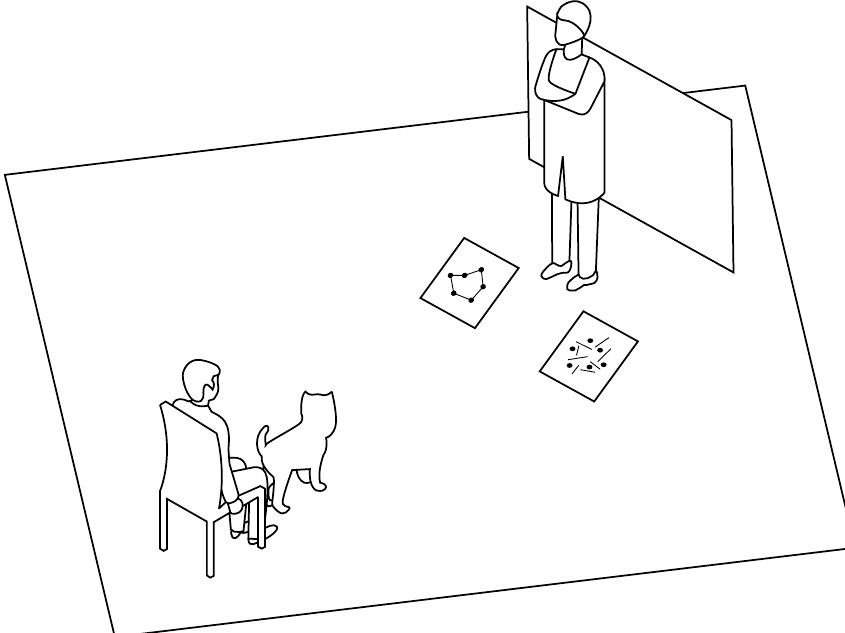
Figure 2. Representation of the experimental setting, illustrating the position of the dog, the owner, the experimenter and the stimuli, during a presentation, before the dog was allowed to choose. Figure not to